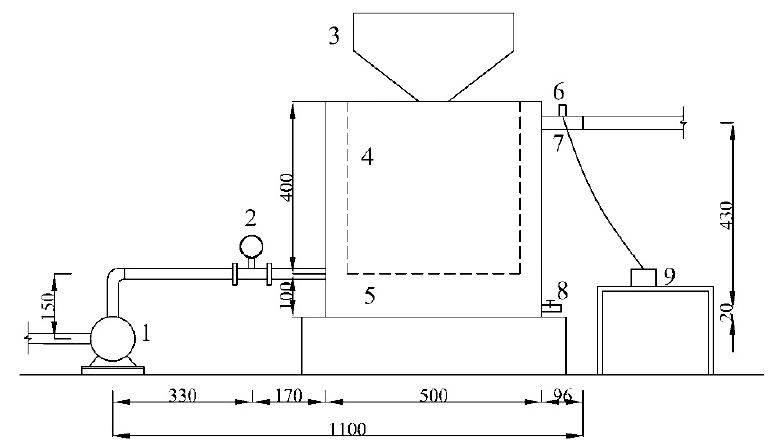
Figure 4. Configuration of the experimental device for evaluating the fertilization uniformity of the designed fertigation device. (unit: mm). 1. DC pump 2. Flowmeter 3. Fertilizer-feeding component 4.